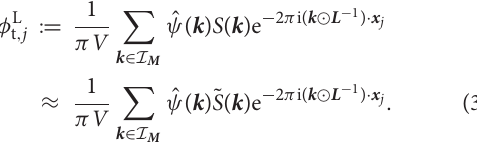
Algorithm 3.1 (Choice of the splitting parameter α and the far field cutoff M